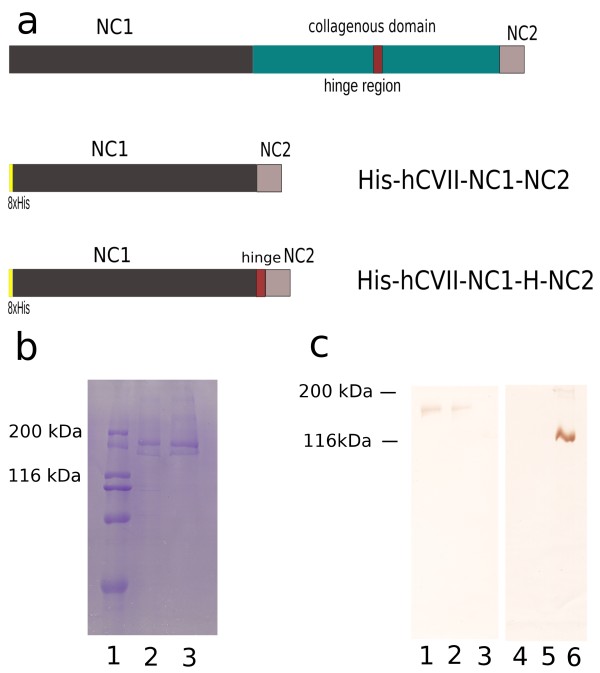
Recombinant forms of collagen VII used in this study. (a) Schematic representation of human collagen VII consisting of a central collagenous domain flanked by a large, 145 kDa N-terminal non-collagenous domain and a smaller, 30 kDa non-collagen domain at its C-terminus. The collagenous domain is interrupted by a 39 amino acid non-collagenous hinge region. The recombinant forms of collagen VII generated in this study are two N-terminally 8xhistidine tagged chimeric proteins termed His-hCVII-NC1-NC2 and His-hCVII-NC1-H-NC2 corresponding to the fused NC1 and NC2 domains (aa 1-1278, 2776-2944) and to the fused NC1, hinge and NC2 regions (1-1278, 1940-1979, 2776-2944) of the antigen, respectively. (b) Sodium dodecylsulfate-polyacrylamide gel electrophoresis of the purified recombinant His-hCVII-NC1-NC2 and His-hCVII-NC1-H-NC2 proteins shows their migration at around 153 (lane 2) and 158 kDa (lane 3), respectively. Weight markers of 200, 116, 97, 66 and 45 kDa are shown in lane 1. (c) Immunoblot analysis of the two recombinant proteins His-hCVII-NC1-NC2 (lanes 1 and 4) and His-hCVII-NC1-H-NC2 (lanes 2 and 5) as well as a recombinant form of collagen XVII [47] (lanes 3 and 6) using a monoclonal antibody specific to the NC1 domain of collagen VII (clone LH7.2; lanes 1-3) and a monoclonal antibody specific to soluble ectodomain of collagen XVII [47] (lanes 4-6).